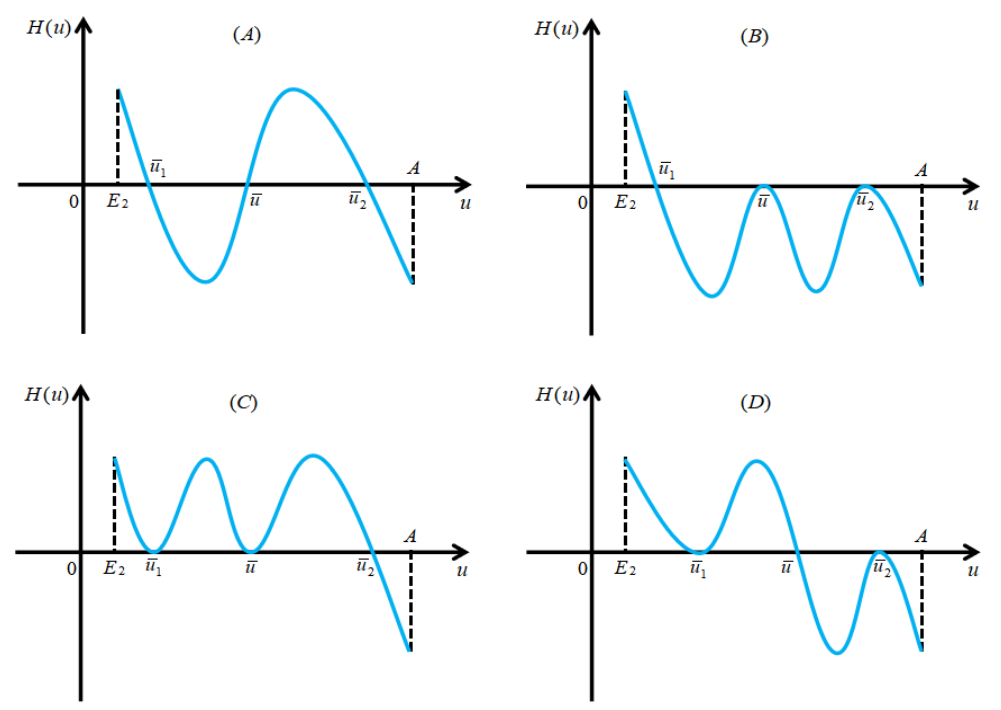
Figure 3. Schematic illustrations of the signs of H (cid:48) ( ¯ u ) . Panels ( A – C ) manifest H (cid:48) ( ¯ u ) ≥ 0, and panel ( D ) represents H (cid:48) ( ¯ u ) < 0.